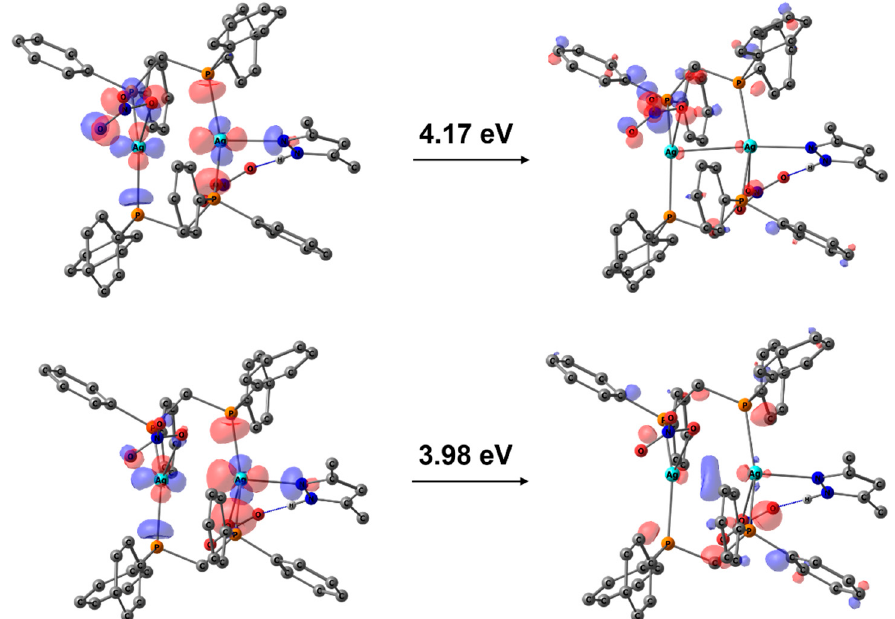
Figure 7. HONTO and LUNTO for the S 0 → S 2 and S 0 → T 11 in complex 2a as the isosurface at 0.05 au.